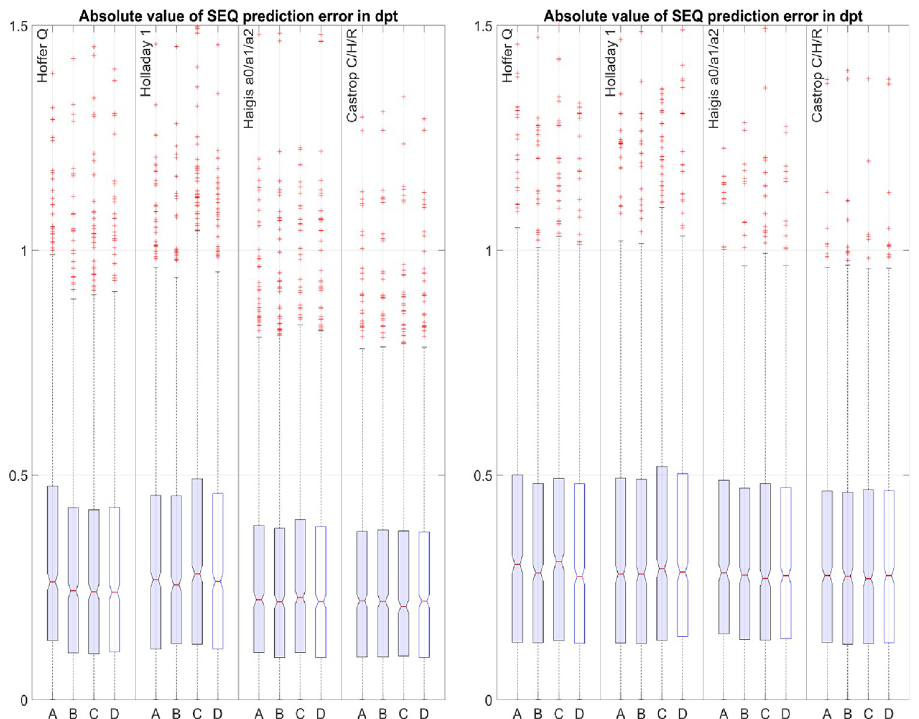
Fig 1. Boxplots of the absolute value of prediction error (PE, measured spherical equivalent refraction–formula predicted refraction) for the Hoffer Q, Holladay1, Haigis, and Castrop formulae for dataset 1 (Hoya Vivinex, N = 888, left graph) and dataset 2 (Alcon SA60AT, N = 822, right graph). Formula constant optimisation was performed to minimise the sum of squared prediction errors PE: Situation A refers to the ‘classical’ formulae with standard nK/nC values; with situation B the formula constants and nK/nC in the main part of the formula were varied for optimisation; with situation C the formula constants and nK/nC in the main part of the formula were varied to minimise for PE and the PE trend error over corneal radius; with situation D) a standard optimisation was performed using the nK/nC value from situation B derived from the other dataset in terms of a cross-validation.